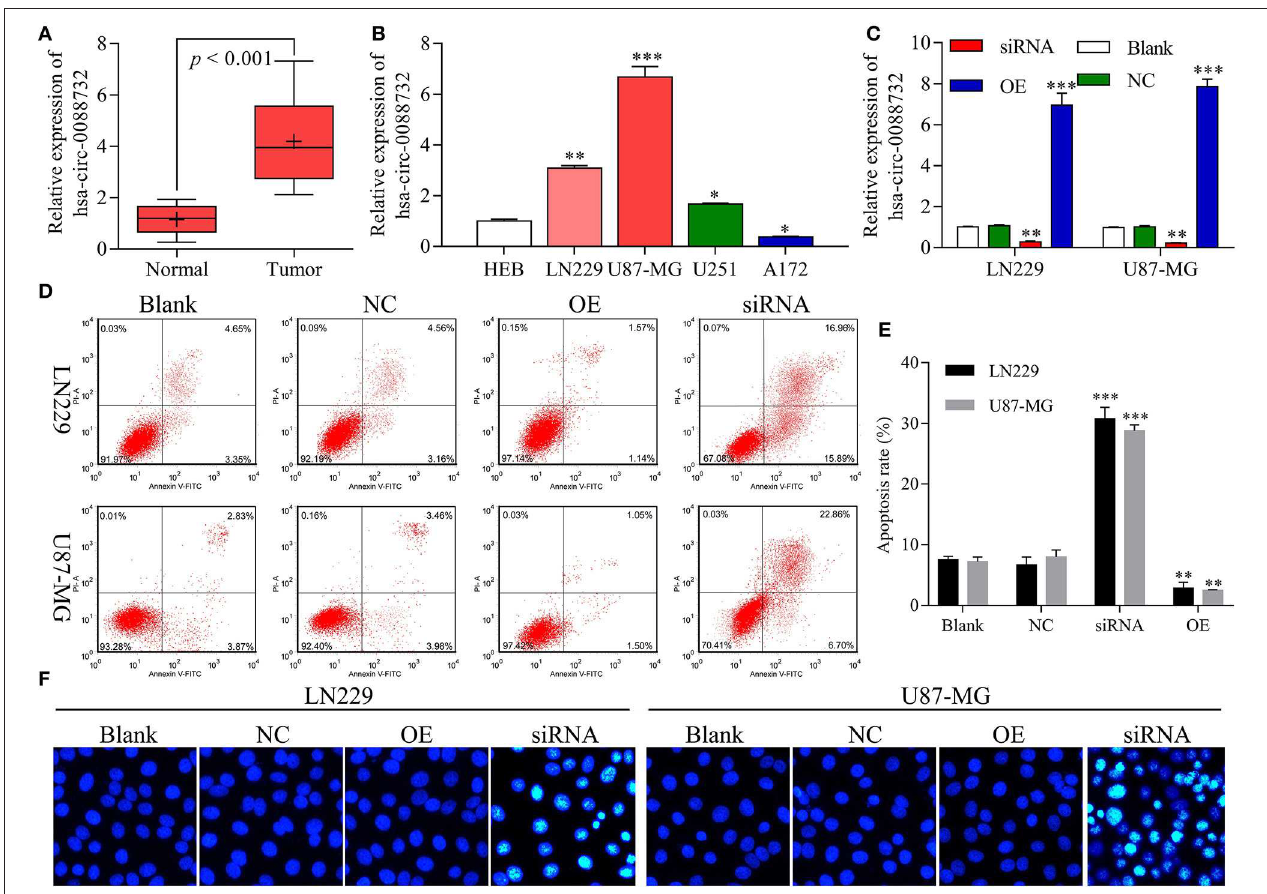
FIGURE 2 | hsa_circ_0088732 regulated glioma cell apoptosis. (A) qRT-PCR assays were performed to detect the expression of hsa_circ_0088732 in 20 pairs of glioma and adjacent non-tumor tissues ( P < 0.001). (B) qRT-PCR assays were performed to assess the expression of hsa_circ_0088732 in HEB and glioma cells, including LN229, U87-MG, U251, and A172 cells (* P < 0.05, ** P < 0.01, *** P < 0.001). (C) Knockdown or overexpression of hsa_circ_0088732 in LN229 and U87-MG cells was determined by qRT-PCR assays (** P < 0.01). (D–F) PI/Annexin V FITC and Hoechst 33258 staining were used to evaluate cell